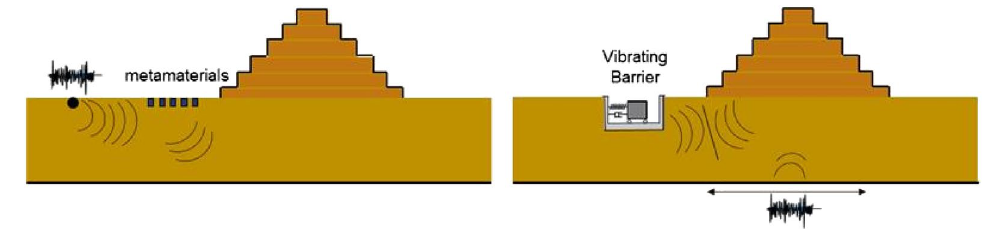
Figure 1. Schematic representation of the working principles of two modern non-local seismic protection systems; in panel ( a ) the seismic metamaterials able to scatter the Rayleigh waves and in panel ( b ), the vibrating barrier technology exploiting the mutual interaction between the device and the structure to be